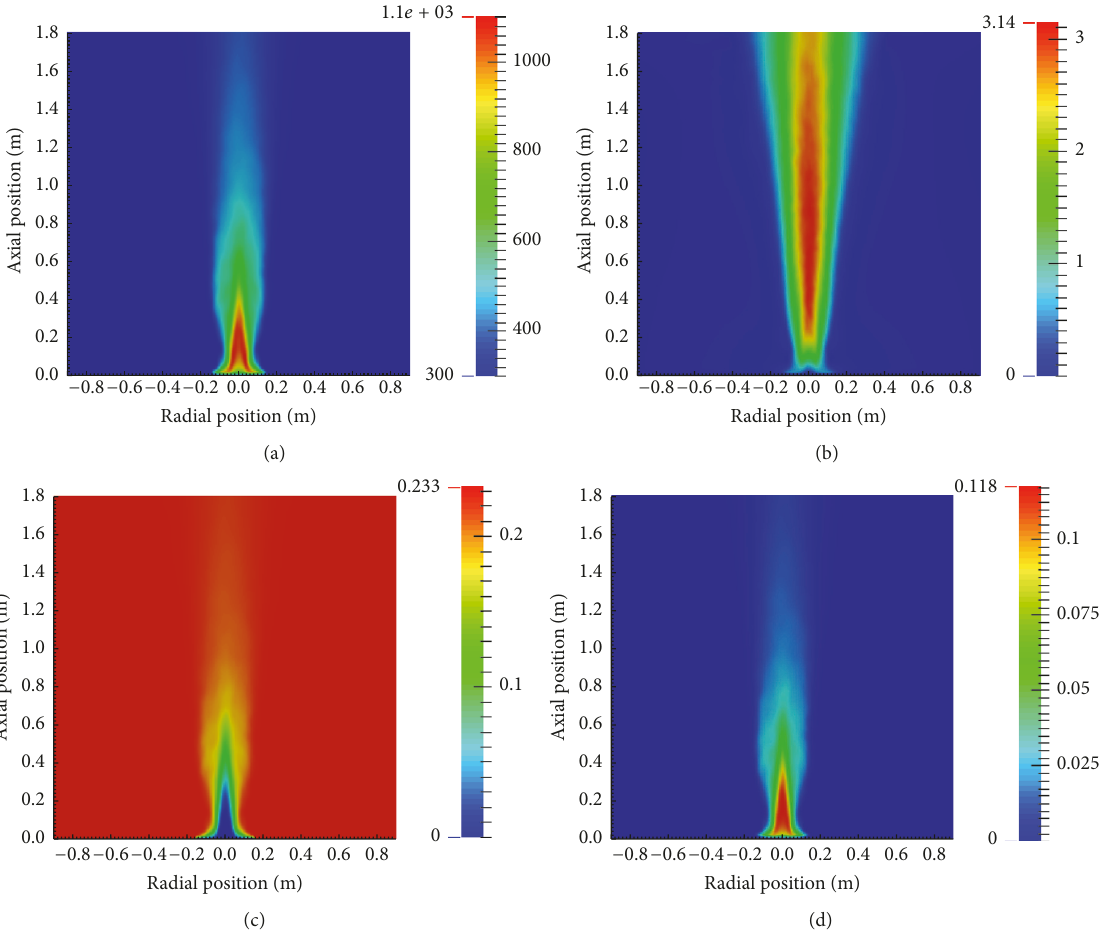
Figure 6: Time averaged contours for the SF mesh. (a) Temperature [K]; (b) velocity magnitude [m/s]; (c) O2 mass fraction; (d) CO2 mass